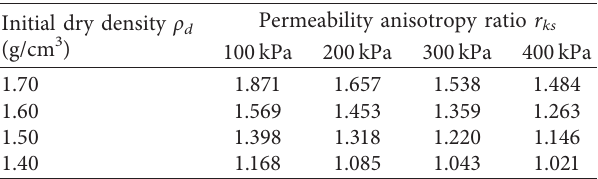
Table 5: Permeability anisotropy ratio of saturated compacted loess under confining pressure